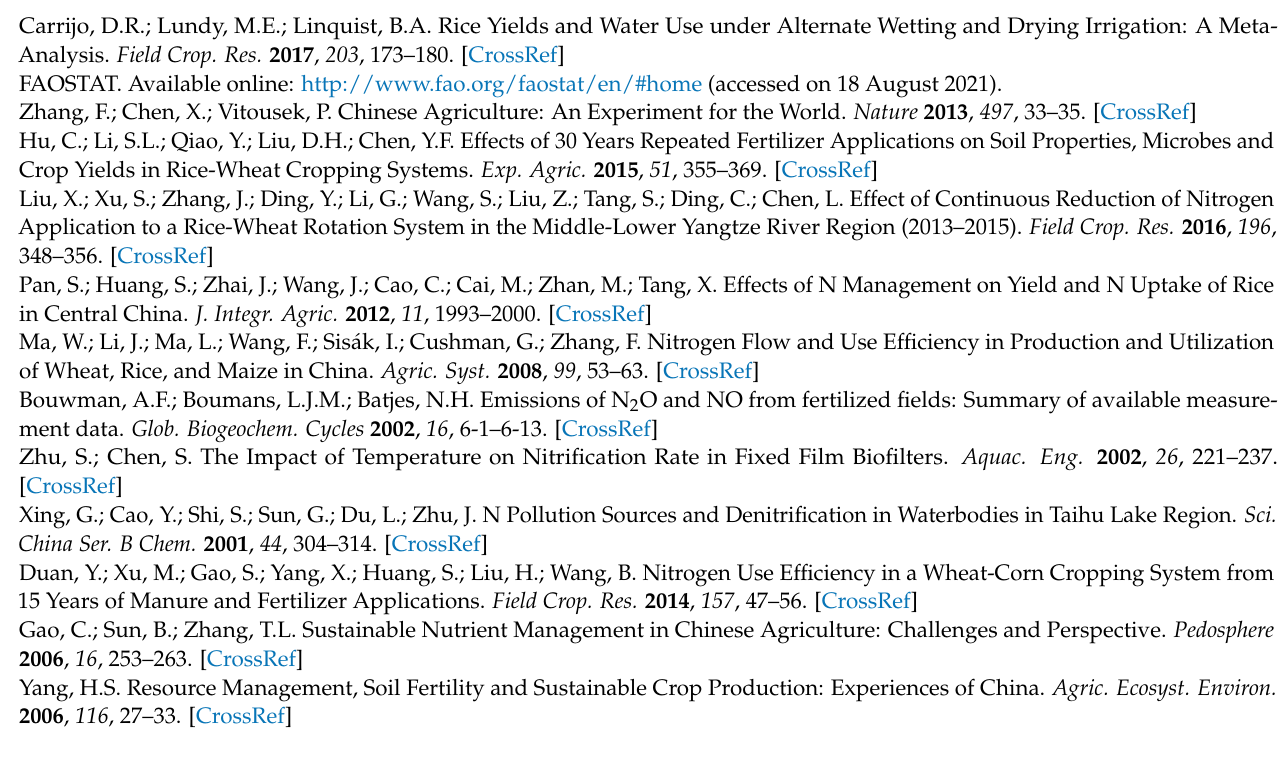
experimental soil before the experiment. Table S2: Indices of NH 4+ -N under different N input rates during wheat seasons in the three-year experiment (2015–2018). Table S3: Indices of NH 4+ -N under different N input rates during rice growing seasons in the three-year experiment (2016–2018). Table S4: Indices of NO 3 -N under different N input rates during three wheat growing seasons (2015–2018). Table S5: Indices of NO 3 -N under different N input rates during the three rice growing seasons